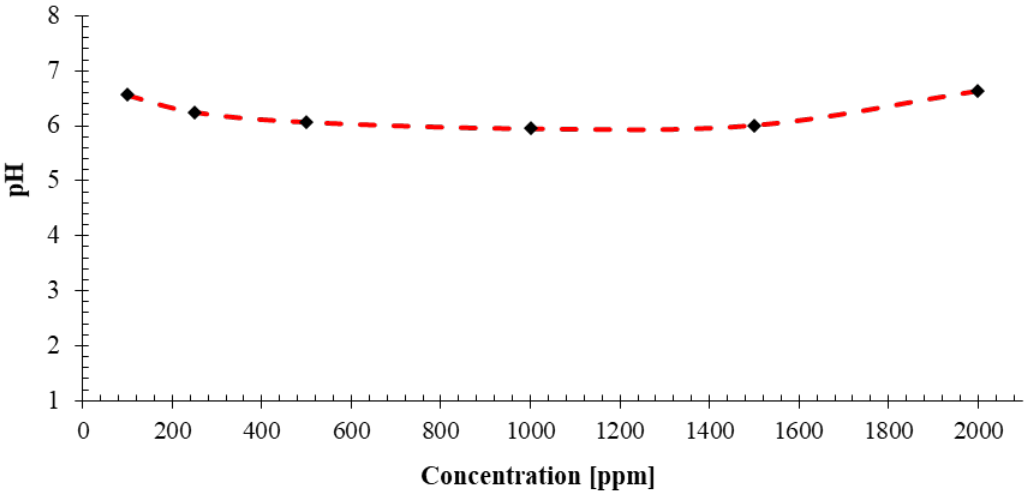
Figure 8. Density of the nanofluids prepared with different concentrations of the novel NC. There is a linear relationship between the density and concentration of the nanofluids.